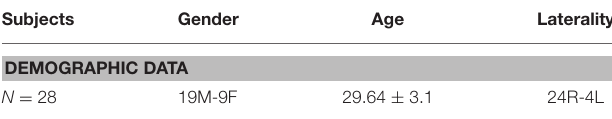
TABLE 1 | Summary of the demographic data of the involved